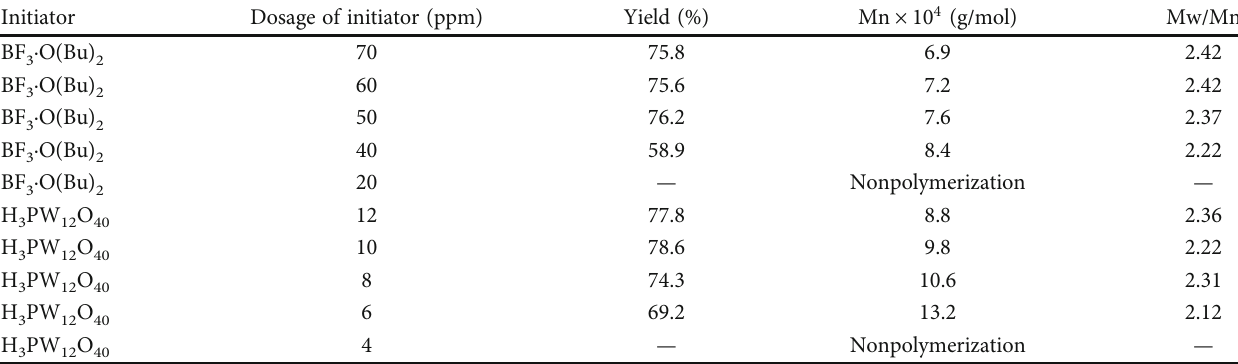
Table 2: Cationic copolymerization of TOX and DOX.